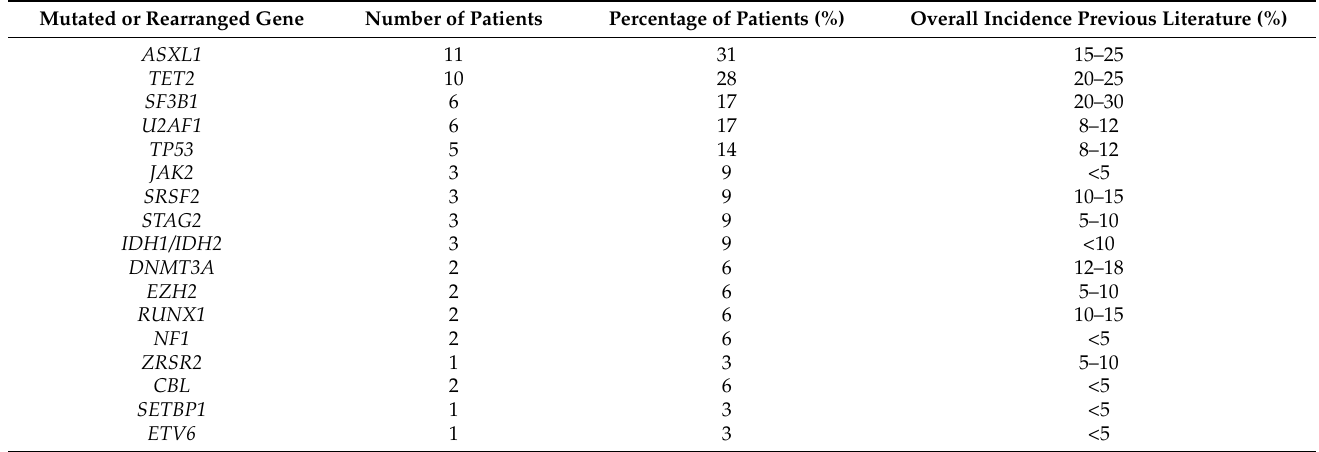
Table 1. Genetic alterations among 34 myelodysplastic syndromes. Number of patients carrying the variant and the corresponding percentage to this number. Prevalence of mutations observed in this series and prevalence reported in the